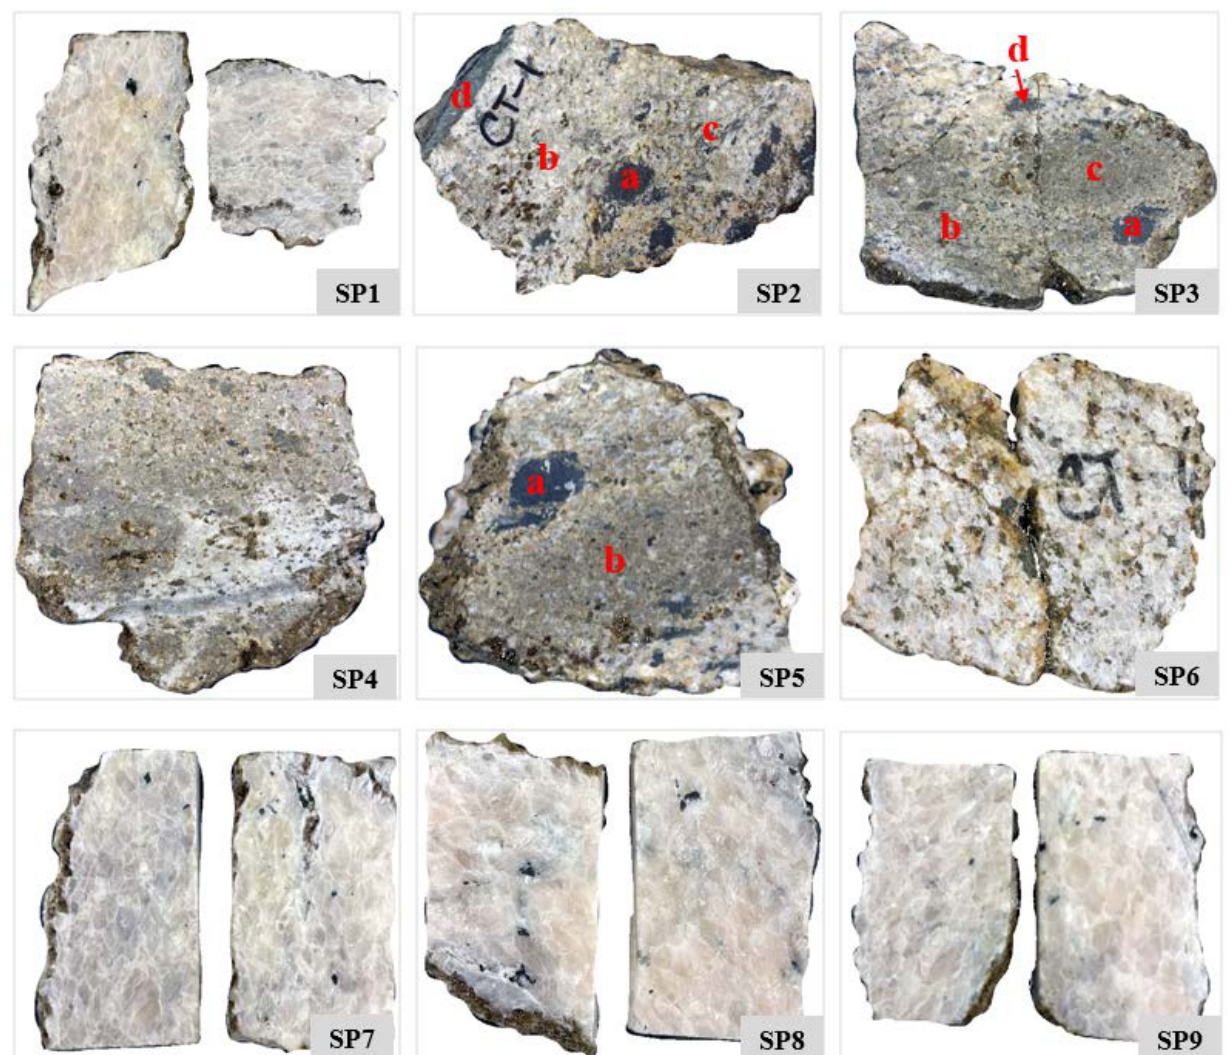
Figure 4. The Sillai Patti carbonatite samples collected from the field. The red-colored annotations on the samples SP2, SP3, and SP5 represent the points of the ASD spectroradiometer measurements for the spectral signatures. The spectra obtained at each of these points are shown in Figure 7.